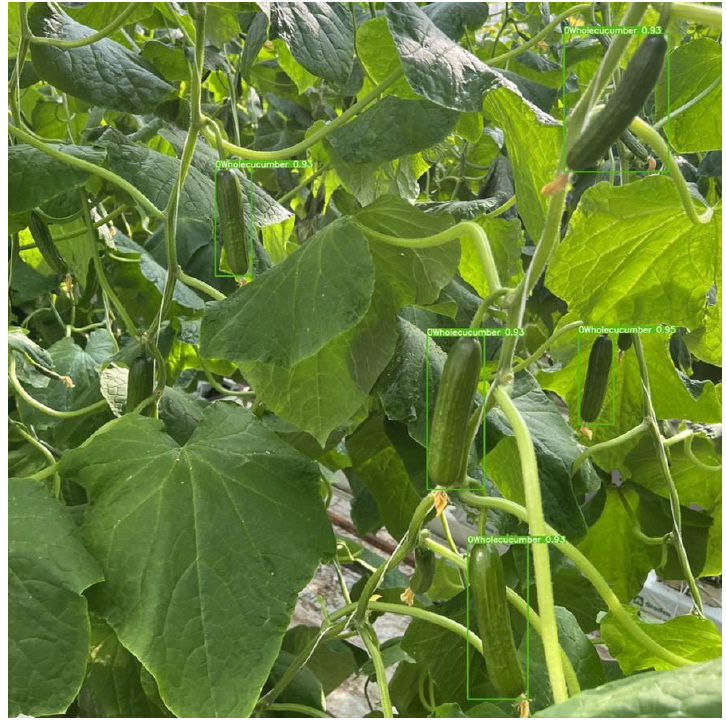
Figure 9. Detection effect of the original YOLOv5s models.